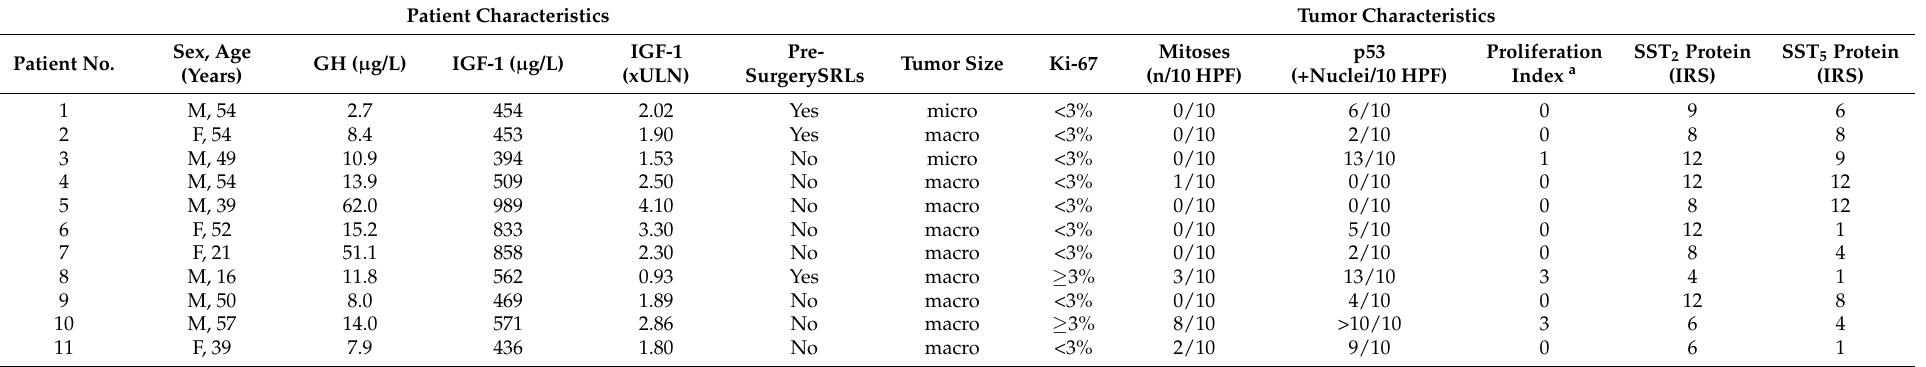
Table 1. General, clinical and biochemical characteristics of patients at time of surgery and histopathological information of the tumors. Patient Characteristics Tumor